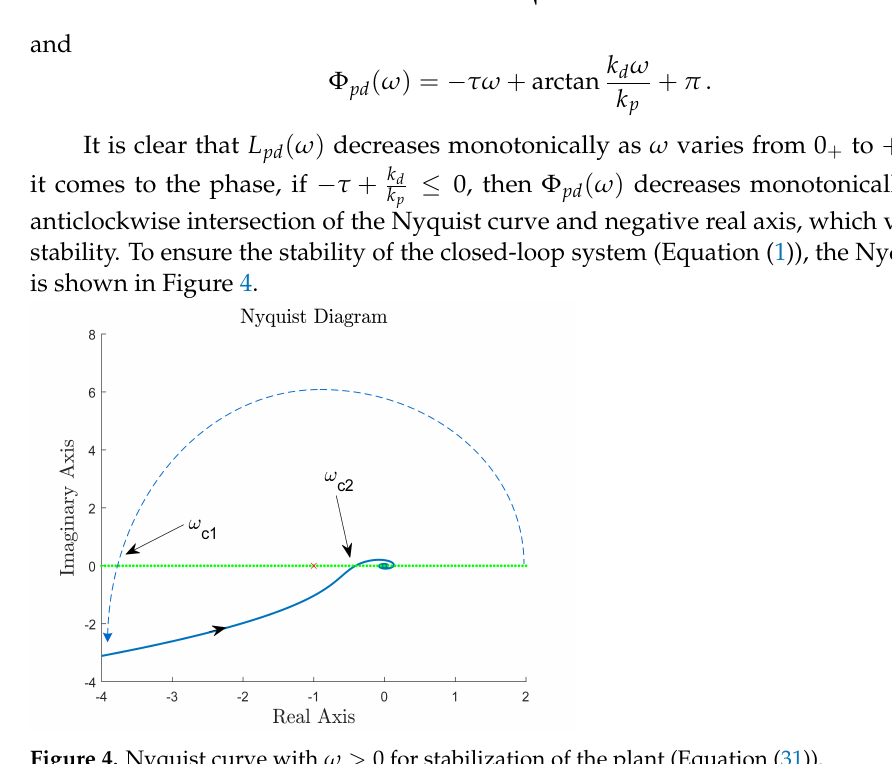
Figure 4. Nyquist curve with ω > 0 for stabilization of the plant (Equation